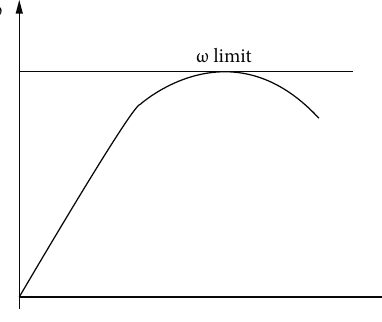
Figure 13: Rotational speed variation versus radial